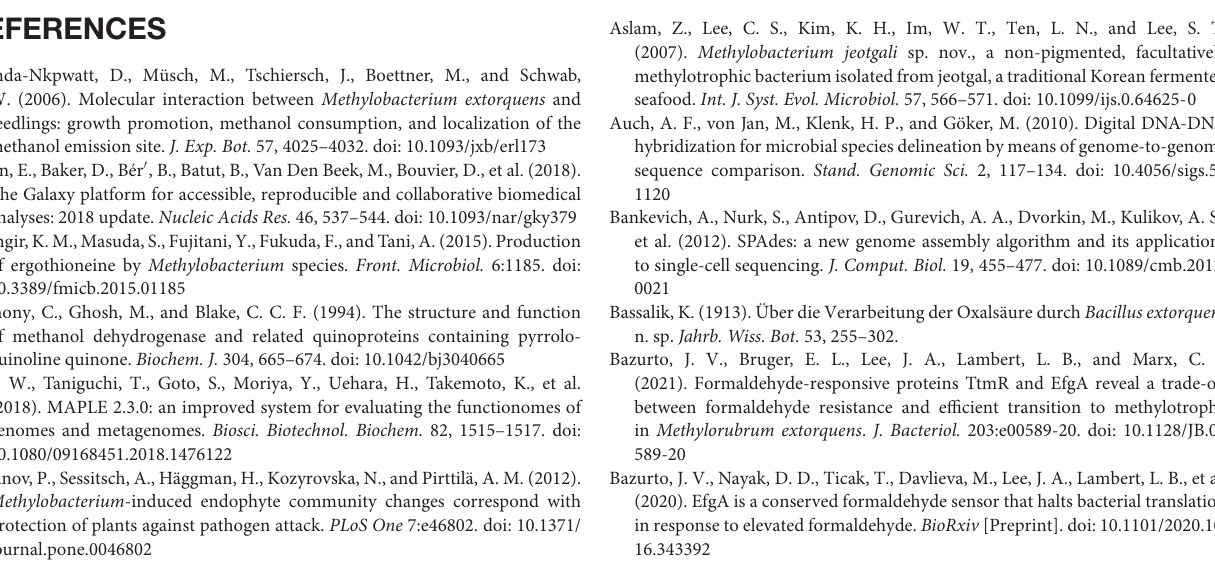
Supplementary Figure 1 | TYGS- 16S rRNA tree. This tree was created from the 16S rRNA gene sequences extracted from the assemblies. The tree shows 59 PPFM species and an outgroup represented by Microvirga brassicacearum T . Supplementary Figure 2 | The correlation of pairwise PCR-derived 16S rRNA gene identity, digital DNA-DNA hybridization (dDDH), and average nucleotide identity (ANI) values among all combinations of PPFMs. (A) The correlation between dDDH and ANI, (B) the correlation between 16S rRNA and ANI, and (C) the correlation between 16S rRNA and dDDH. The lower panels show plots of species combinations with high correlation values. Supplementary Figure 3 | Functional annotation and distribution of core, accessory, and unique genes of the PPFMs within KEGG main groups. (A) KEGG general category, and (B) more specific details of KEGG category. The gene count in each category is shown as a percentage of the total count in each group (core, accessory, and unique). ∗ The overview category includes carbon metabolism (ko01200), oxocarboxylic acid metabolism (ko01210), fatty acid metabolism (ko01212), degradation of aromatic compounds (ko01220), and biosynthesis of amino acids (ko01230). Supplementary Figure 4 | Antifungal activity of PPFMs against Fusarium oxysporum . Among the tested strains, only those with strong inhibition activity are shown. Each PPFM was inoculated onto half of a PDA plate, and the fungus was allowed to grow from the center. The plates were incubated at 25 ◦ C for 7–10 days. Supplementary Figure 5 | Rice cell elicitation assay. The PPFMs were inoculated into rice cell suspension, then incubated for 24 h. The numbers represent the tested species listed in Supplementary Table 13 . DC3000, Pseudomonas syringae DC3000; 1–7 and 4–24, Serratia marcescens subsp. marcescens isolates 1–7 and 4–24; GlcNAc, chitin oligomer (10 nM); and NC, negative control (saline